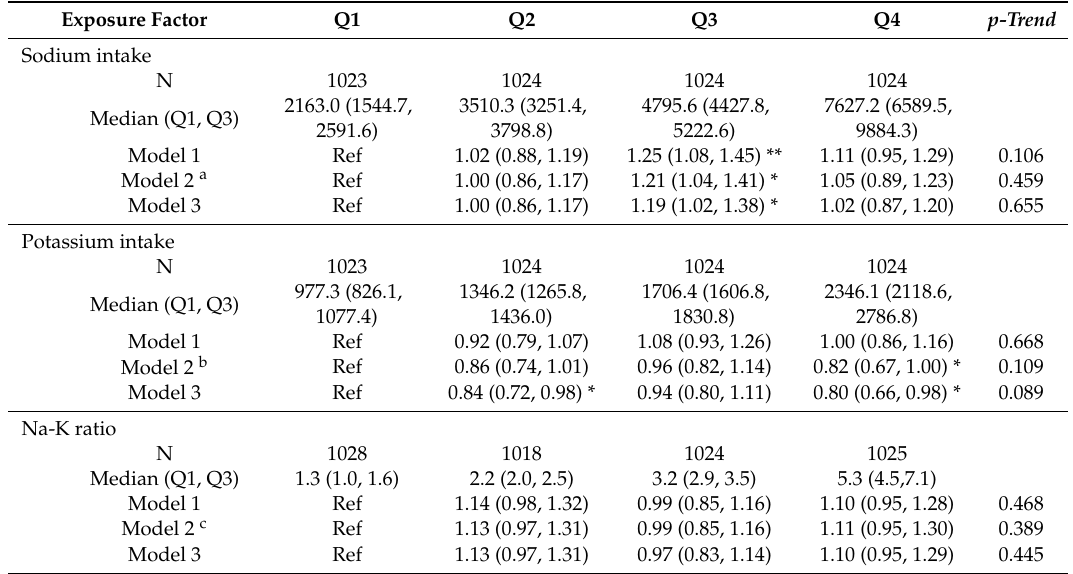
Table 4. Associations between dietary sodium, potassium, and sodium-potassium ratio and risk of hypertension in South